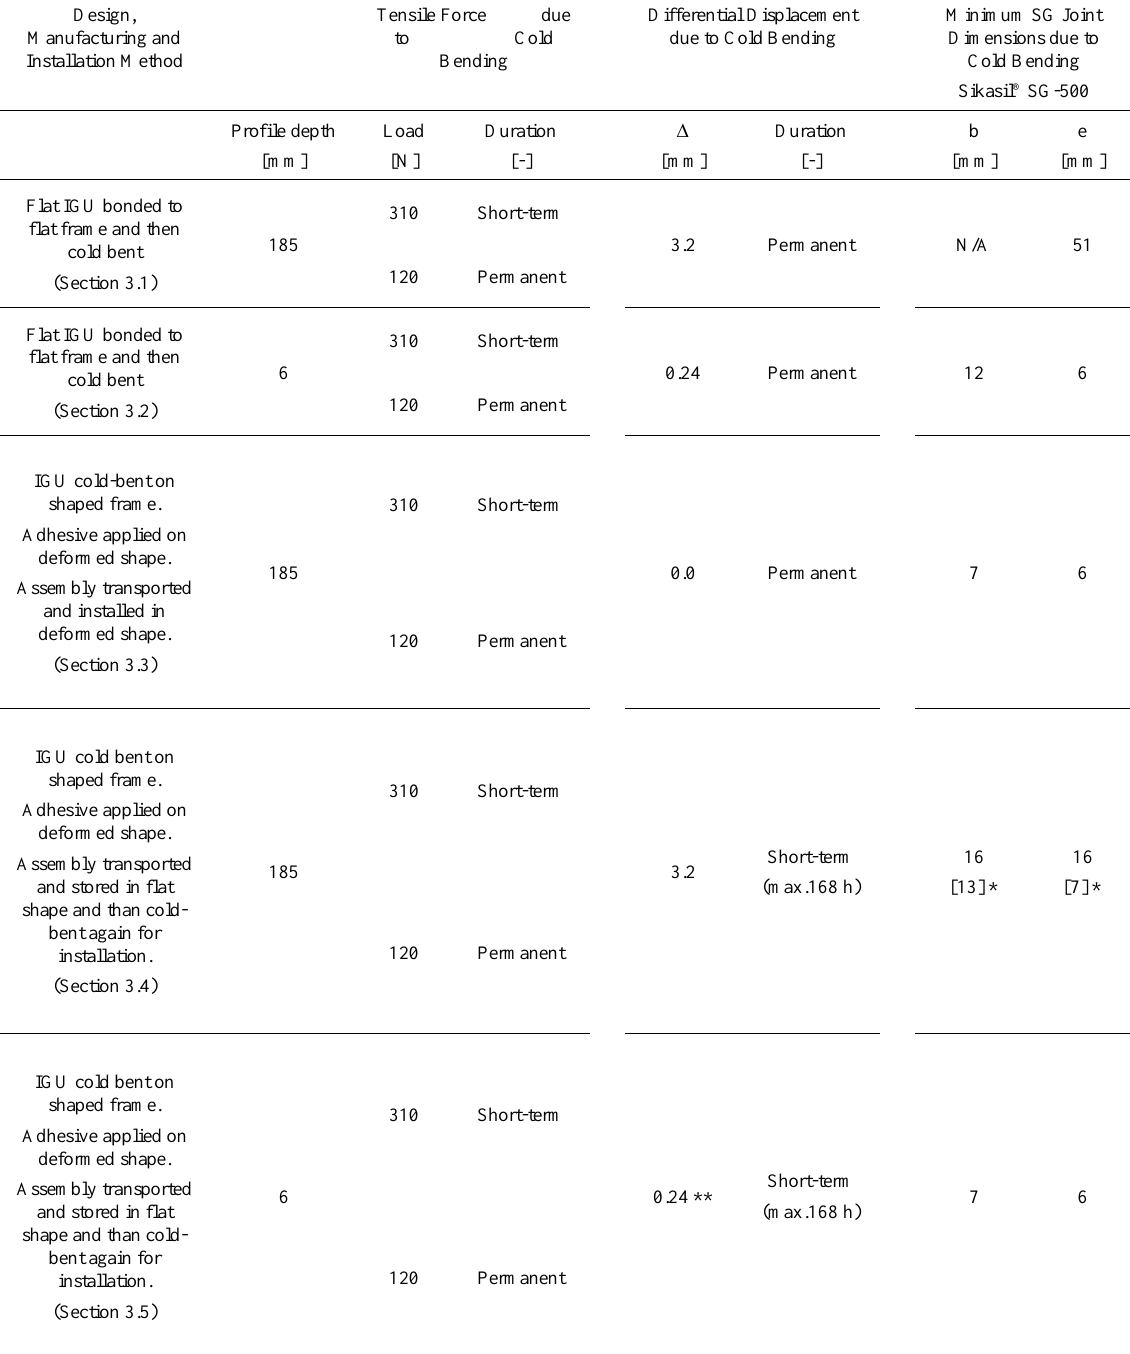
Table 2: Effects of Cold Bending on SG Joints depending on Design, Manufacturing and Installation Method. Design, Manufacturing